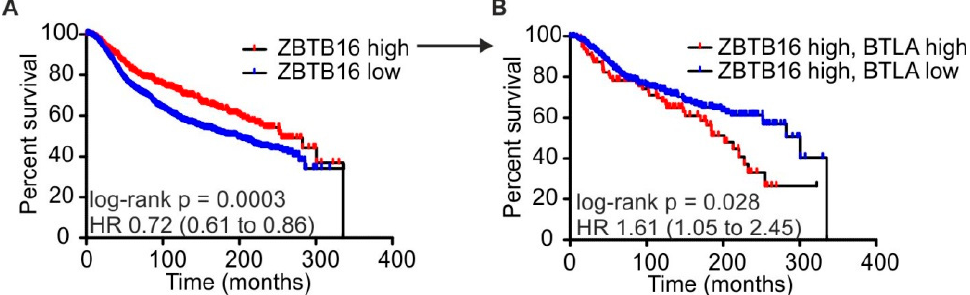
Figure 5. Combined BTLA and ZBTB16 expression predict mammary carcinoma patient survival. The METABRIC dataset (Curtis et al., 2012) was analyzed concerning a correlation of the NKT cells lineage determining transcription factor ZBTB16 and BTLA with overall survival. ( A ) Survival rates of patients expressing high (>75% percentile) or lower (<75% percentile) levels of ZBTB16. ( B ) Survival rates of patients expressing high (>75% percentile) levels of ZBTB16 after further separation into groups expressing high (>75% percentile) or lower (<75% percentile) levels of BTLA. p -values were calculated using log-rank test.